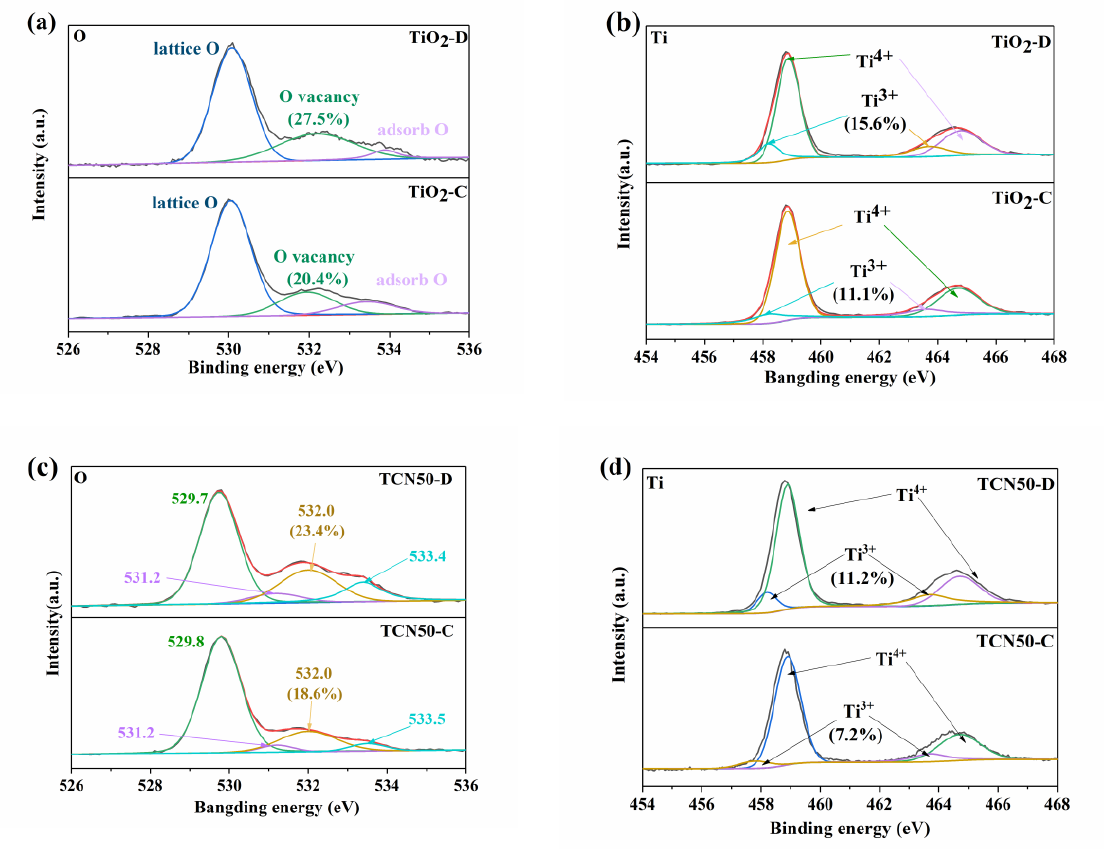
Figure 2. The high-resolution XPS spectra: ( a ) O 1s, ( b ) Ti 2p, of TiO 2 samples. ( c ) O 1s, ( d ) Ti 2p of TCN50 samples.